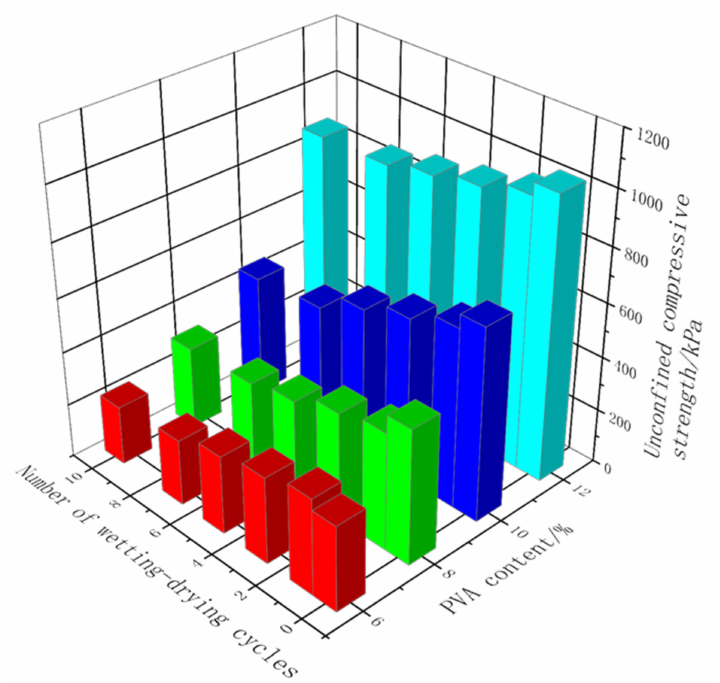
Figure 5. Statistical histogram of UCS of coarse-grained soil samples stabilized by pristine PVA solution after different numbers of wet–dry